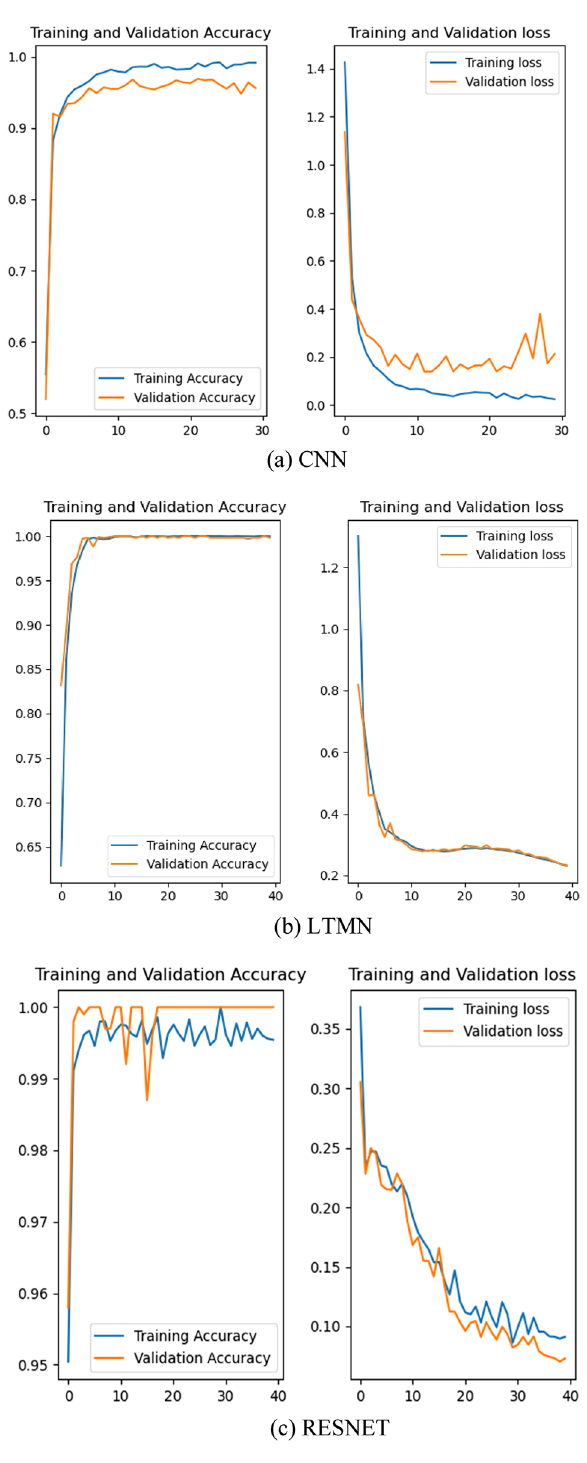
Figure 5. Fault diagnosis results of three kind of neural networks.